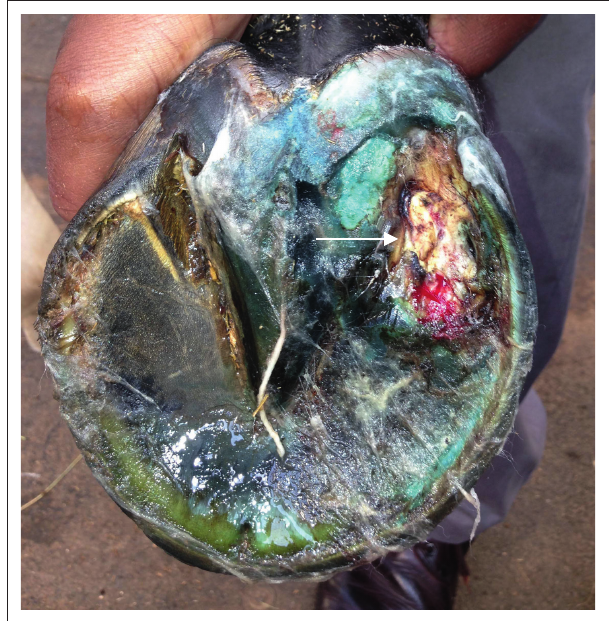
FIGURE 1: Right hind hoof of a four-year-old Thoroughbred gelding racehorse, showing the location of a keratoma in the lateral quarter. This photo was taken 5 days